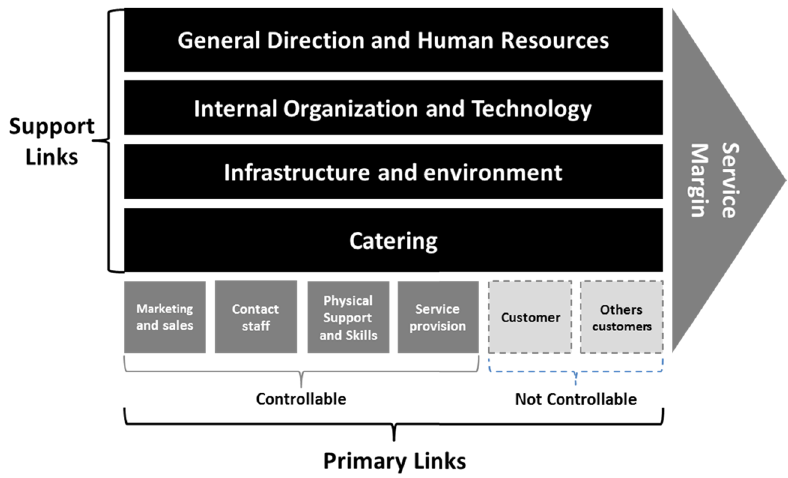
Figure 2: Value chain proposed by Alonso ( 2008 ) . Source: Alonso ( 2008, 89 )